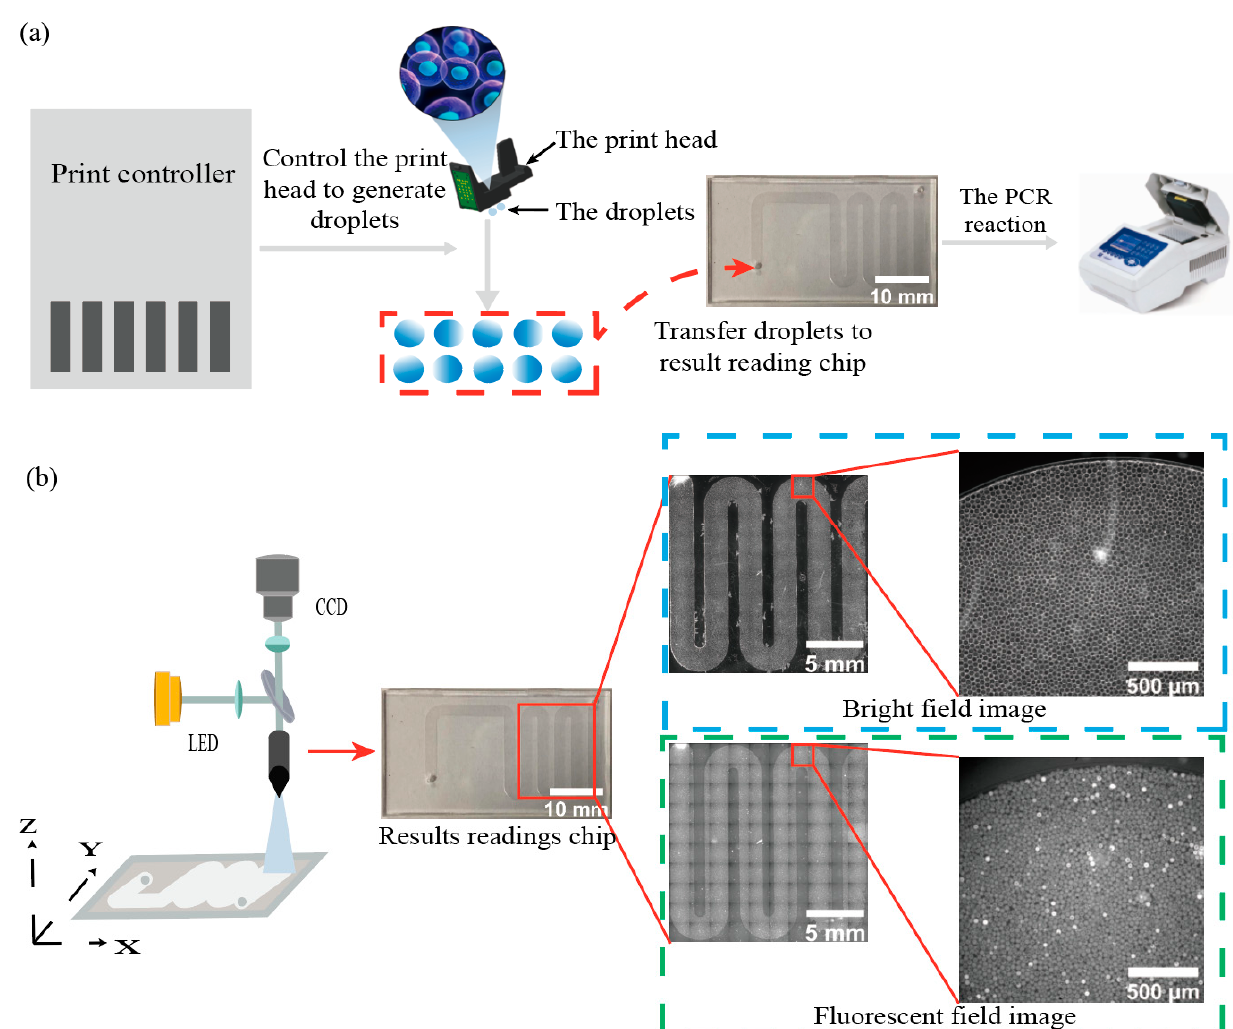
Figure 1. Acquisition of dPCR image data with the high-throughput droplet generation and result reading chip. ( a ) Flow diagram of a thermal bubble inkjet print head generating dPCR droplets, micro-droplets at the 24 pL level, and the generated droplets are transferred to a result reading